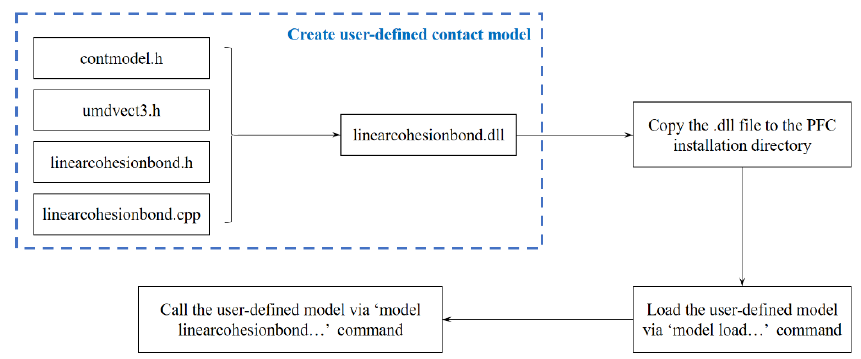
Figure 6. Flow chart of user-defined contact model implementation.